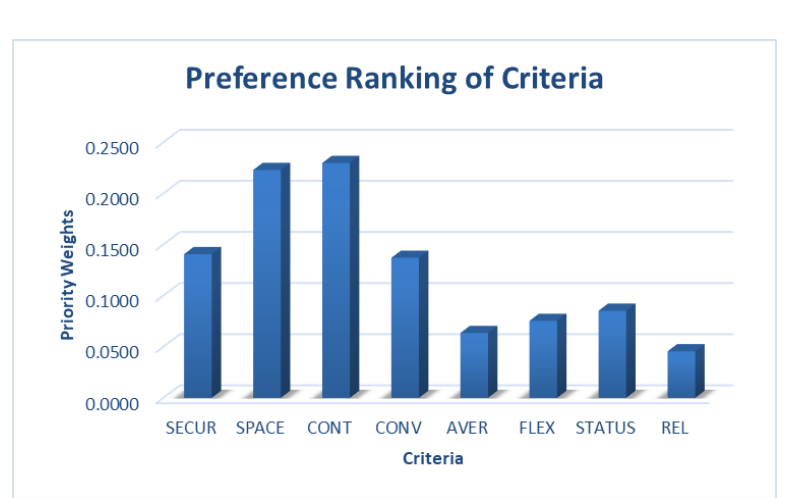
Figure 2. Preference ranking of